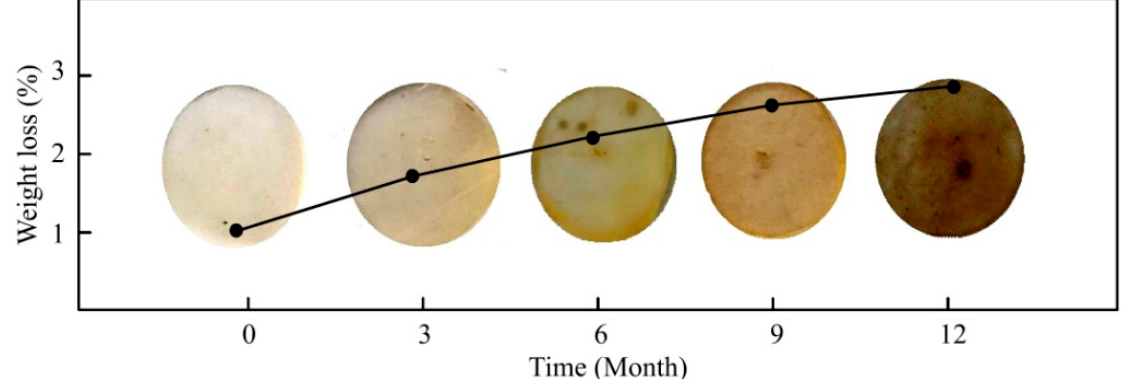
Figure 1. Weight loss and color change of PA films.